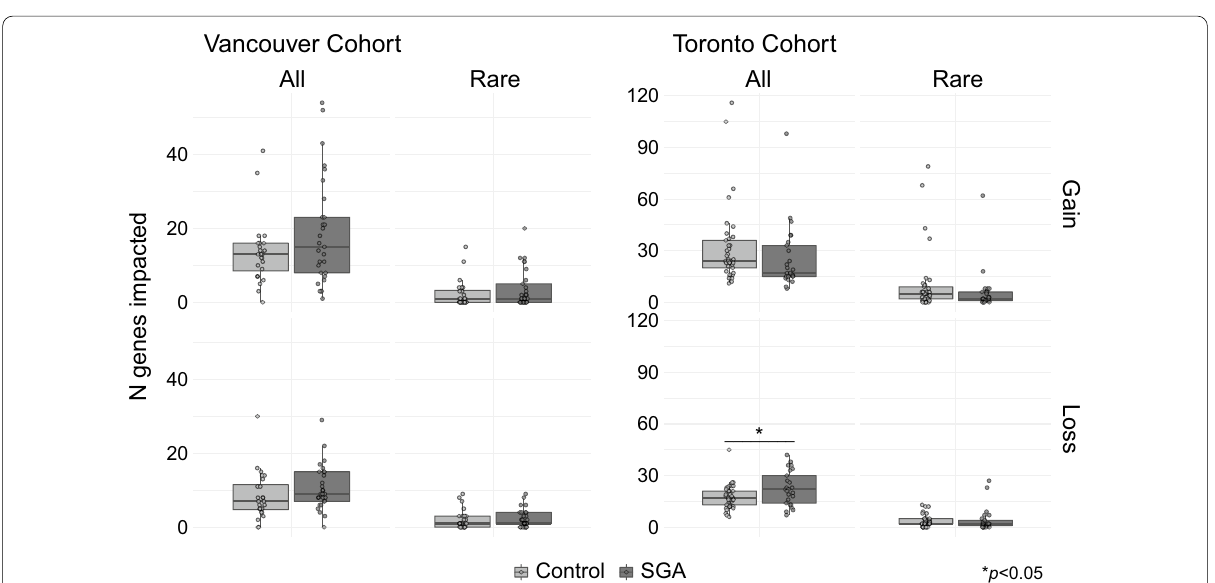
Fig. 3 Total number of genes impacted by placental CNVs from control and SGA pregnancies. The cumulative total of unique RefSeq genes impacted by CNVs for each case in the Toronto and Vancouver cohorts are shown, separated by all CNVs or exclusively rare CNVs, and by gains and losses. Toronto cohort SGA placentas had slightly more genes affected by losses than controls. A similar trend was found in Vancouver cohort, but the difference was not statistically significant. p ‑values calculated by Mann–Whitney